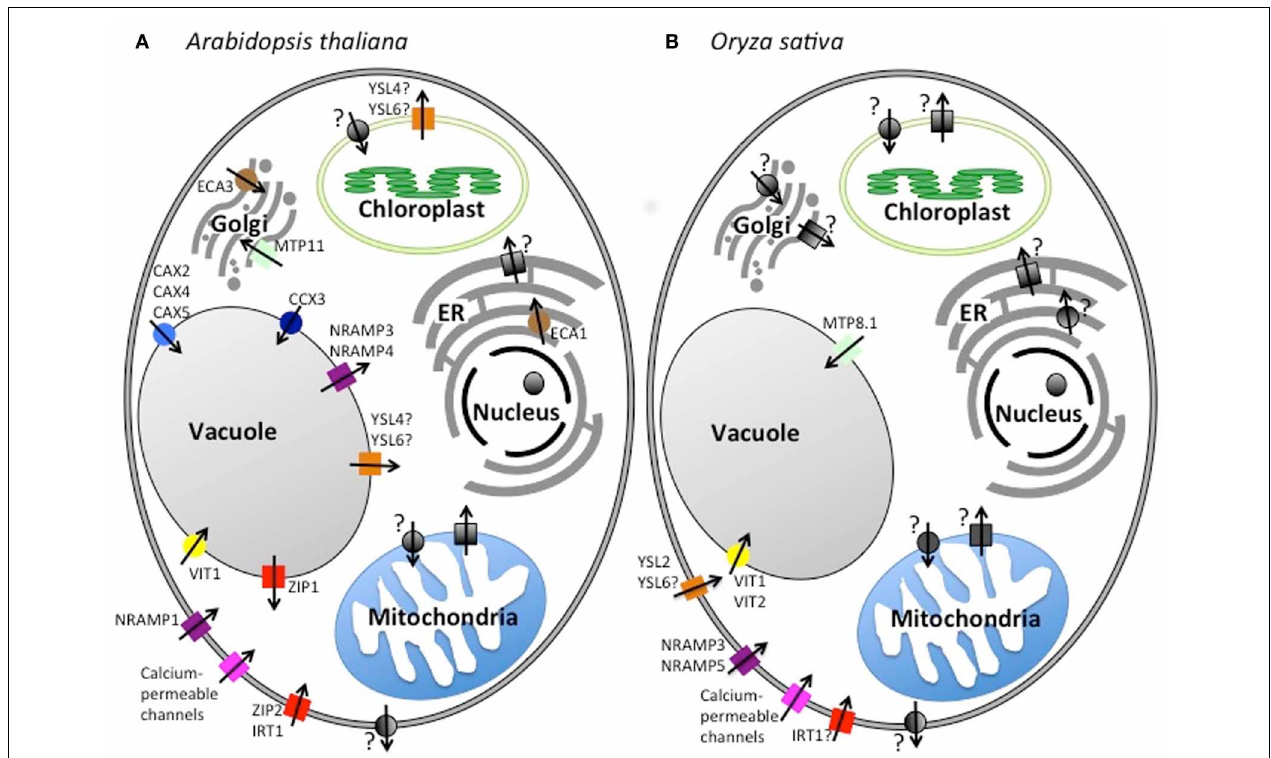
FIGURE 1 | Subcellular localization of putative Mn transporters. A diagram of a plant cell showing the Mn transport pathways in (A) A. thaliana and (B) O. Sativa. Squares, import into the cytosol; Circles, export out of the cytosol; Gray, unknown; Red, ZIP family;